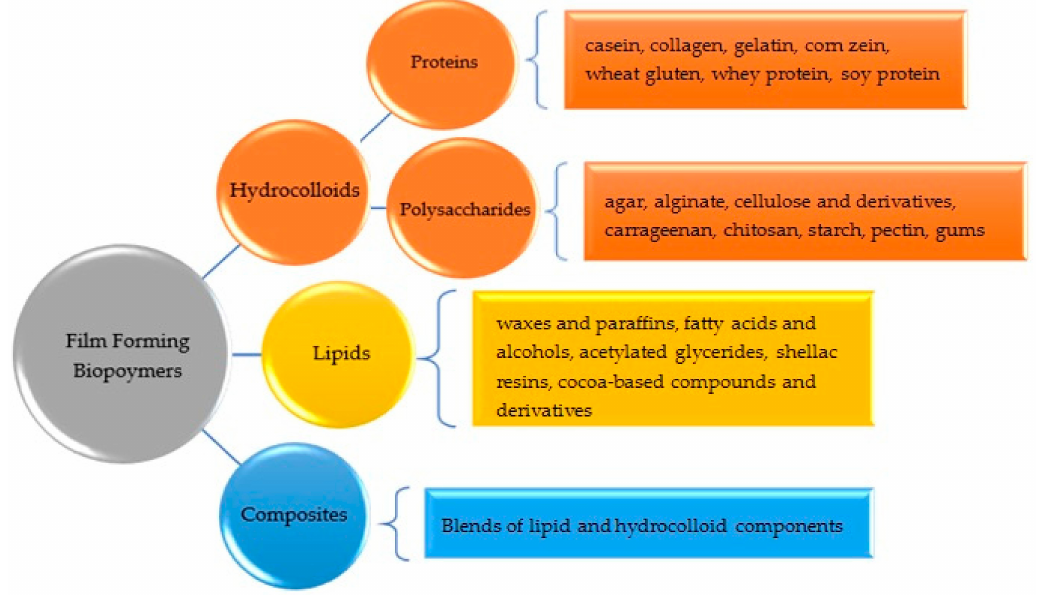
Figure 1. The film-forming biomaterials that have been studied extensively for the formation of edible coatings and films (Donhowe and Fennema [12], Embuscado and Huber